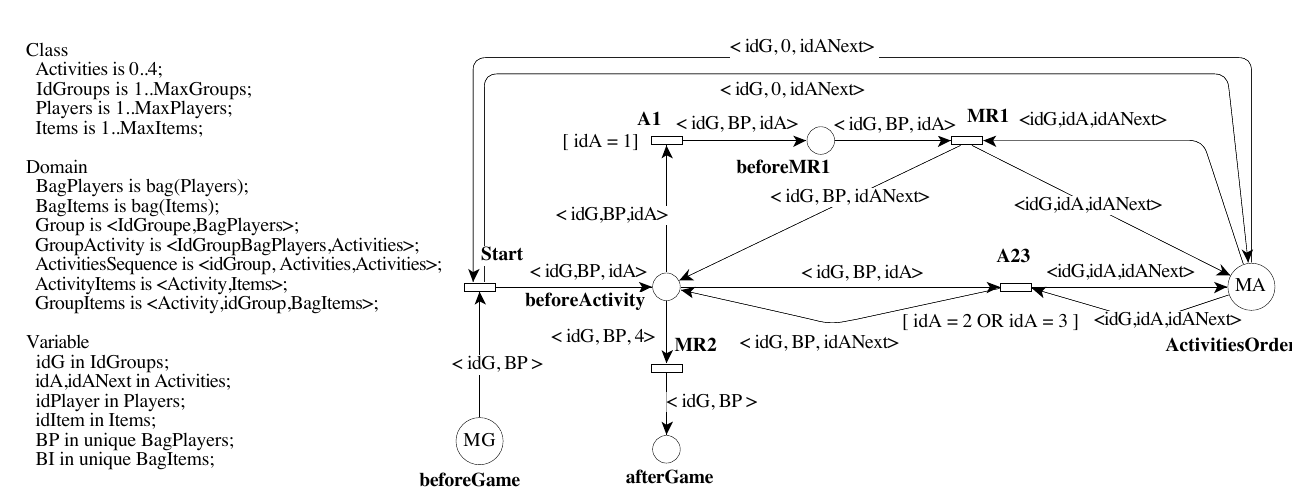
Figure 6. Formal model of the concurrent scenario, the MR